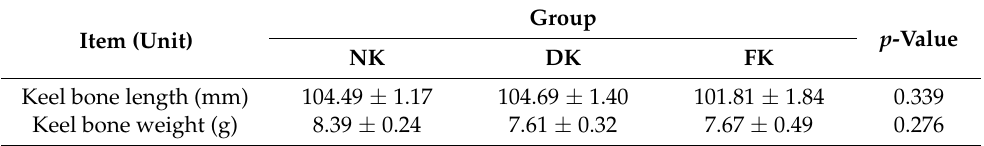
Table 3. Keel bone length and weight of laying hens in three